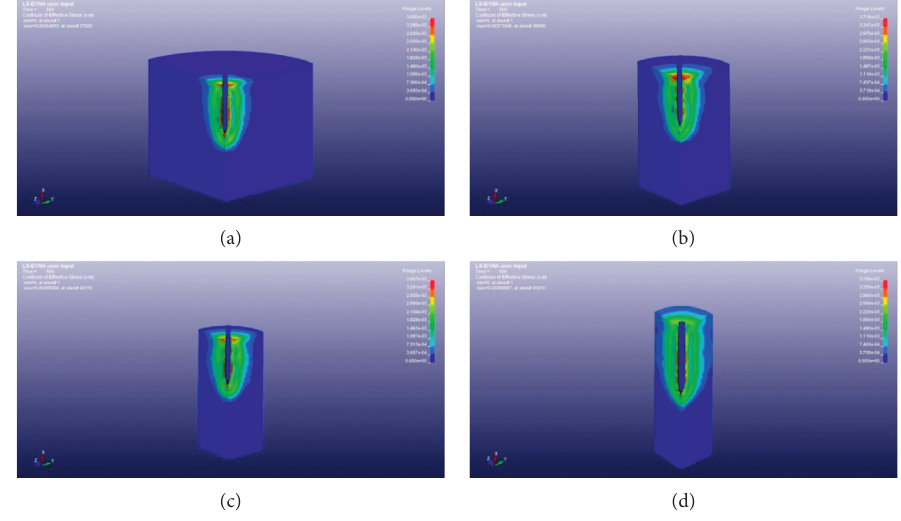
Figure 12: Final form of penetration models with different values of r